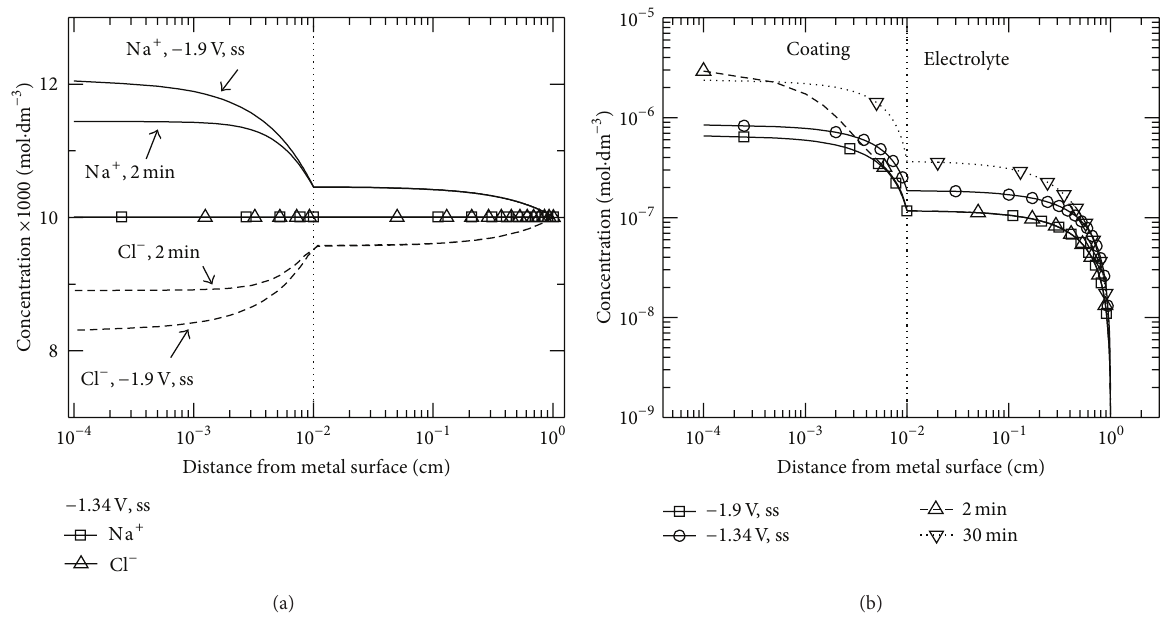
Figure6:(a)Na + andCl − ionand(b)Al 3+ ionconcentrationsasfunctionsofdistancefromthemetalsurfaceacrossthecoatingandelectrolyte for a 0.1mm, 0.02 porosity coating. Included are the steady state distributions at − 1.34 V and − 1.9 V and the transient distributions at 2min and 30min after the applied potential of − 1.9 V were switched off.